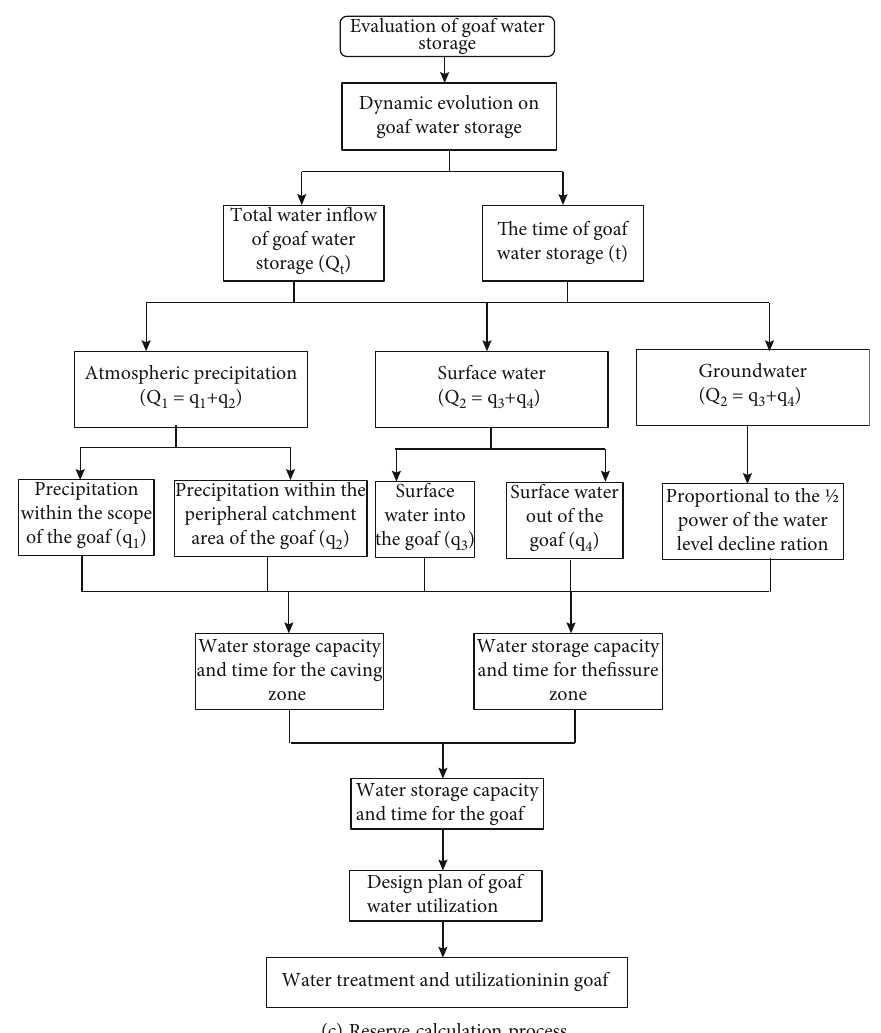
Figure 14: Flowchart of evaluation of water storage in